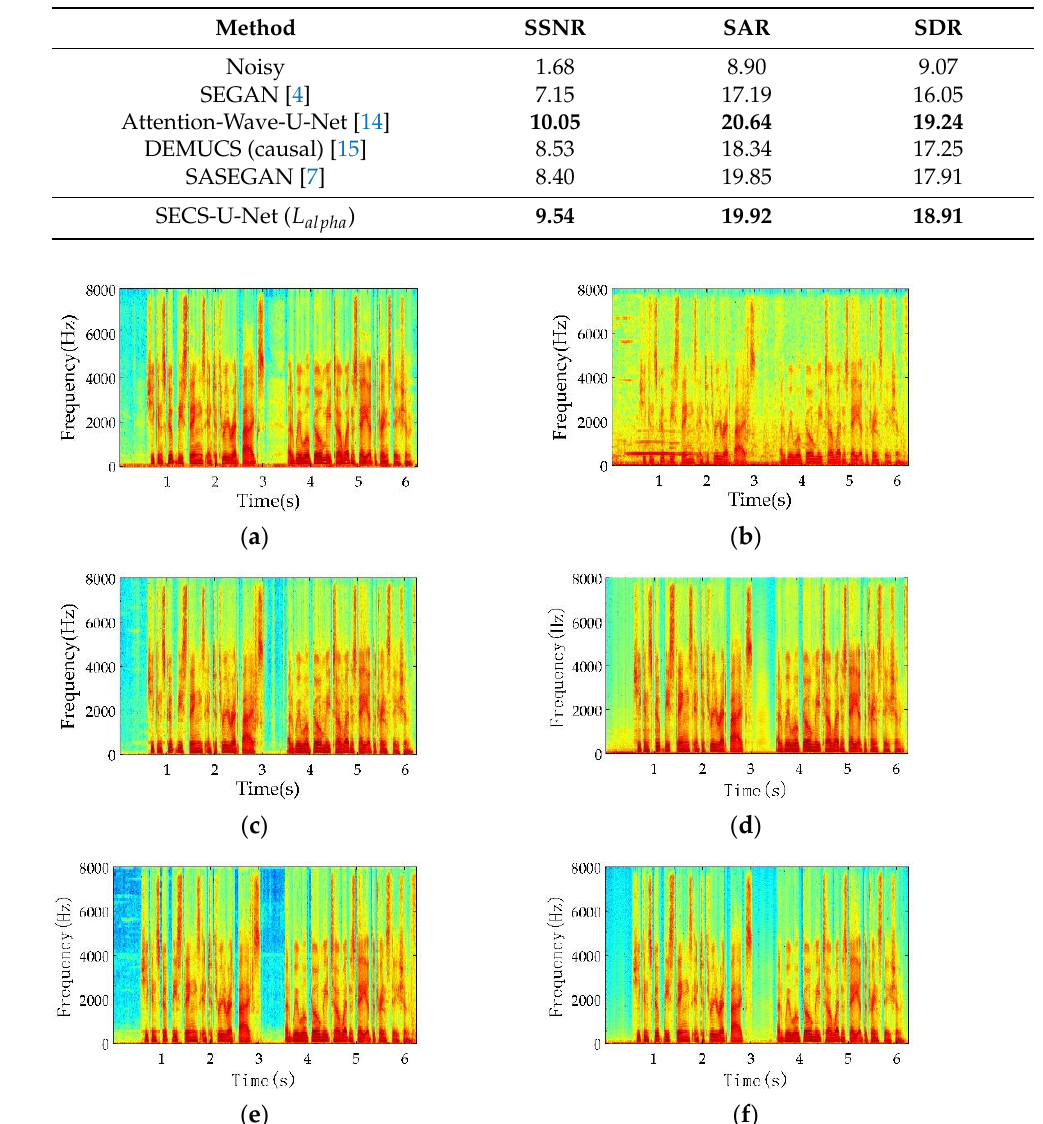
Figure 4. The spectrograms of speech enhanced by ( c ) Attention-Wave-U-Net [14], ( d ) DEMUCS (causal) [15], ( e ) SASEGAN [7] and ( f ) SECS-U-Net ( L alpha )on open test set. The ( a ) and ( b ) are spectrograms of clean and noisy speech, respectively.